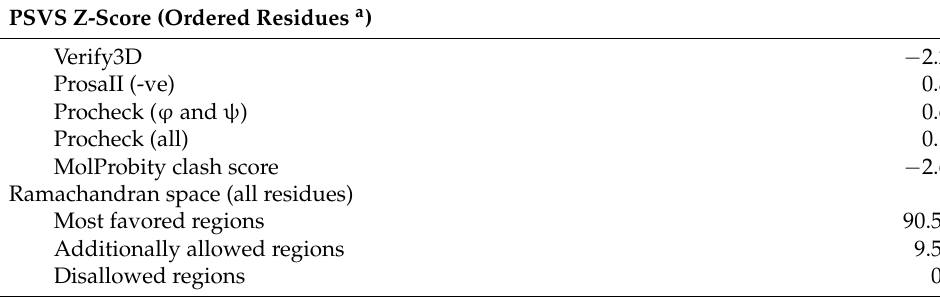
Table 2. Evaluation of the DNAJA1-107 NMR